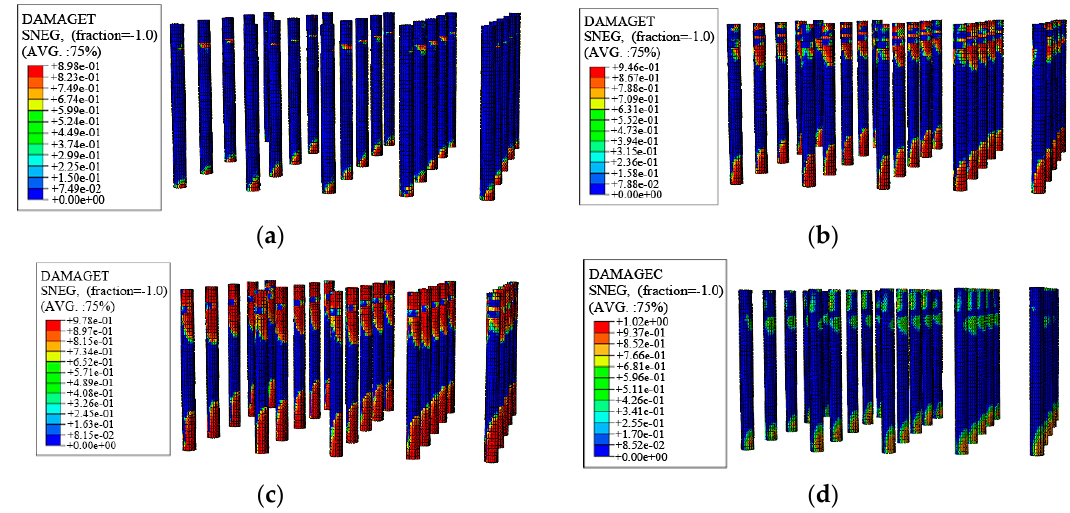
Figure 12. Damage distribution of RC tubular columns subjected to different hazard levels: ( a ) Tensile damage under basic earthquakes; ( b ) tensile damage under rare earthquakes; ( c ) tensile damage under very rare earthquakes; ( d ) compressive damage under very rare earthquakes.